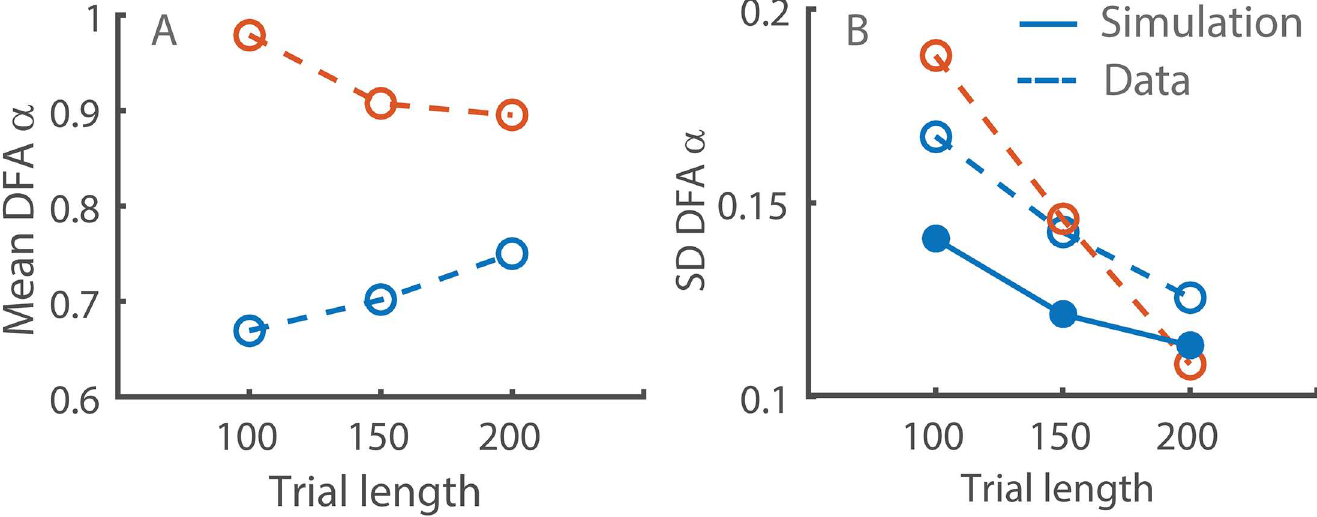
Fig 4. DFA α differences between the synchronization conditions as a function of trial length in experimental data. (A) Between-subject mean DFA α in the self-paced(blue lines) and persistent metronome(orangelines) conditions. (B) Standarddeviationof DFA α in the same conditions. The solid blue line is the predictedbetween-subject variabilityfrom the